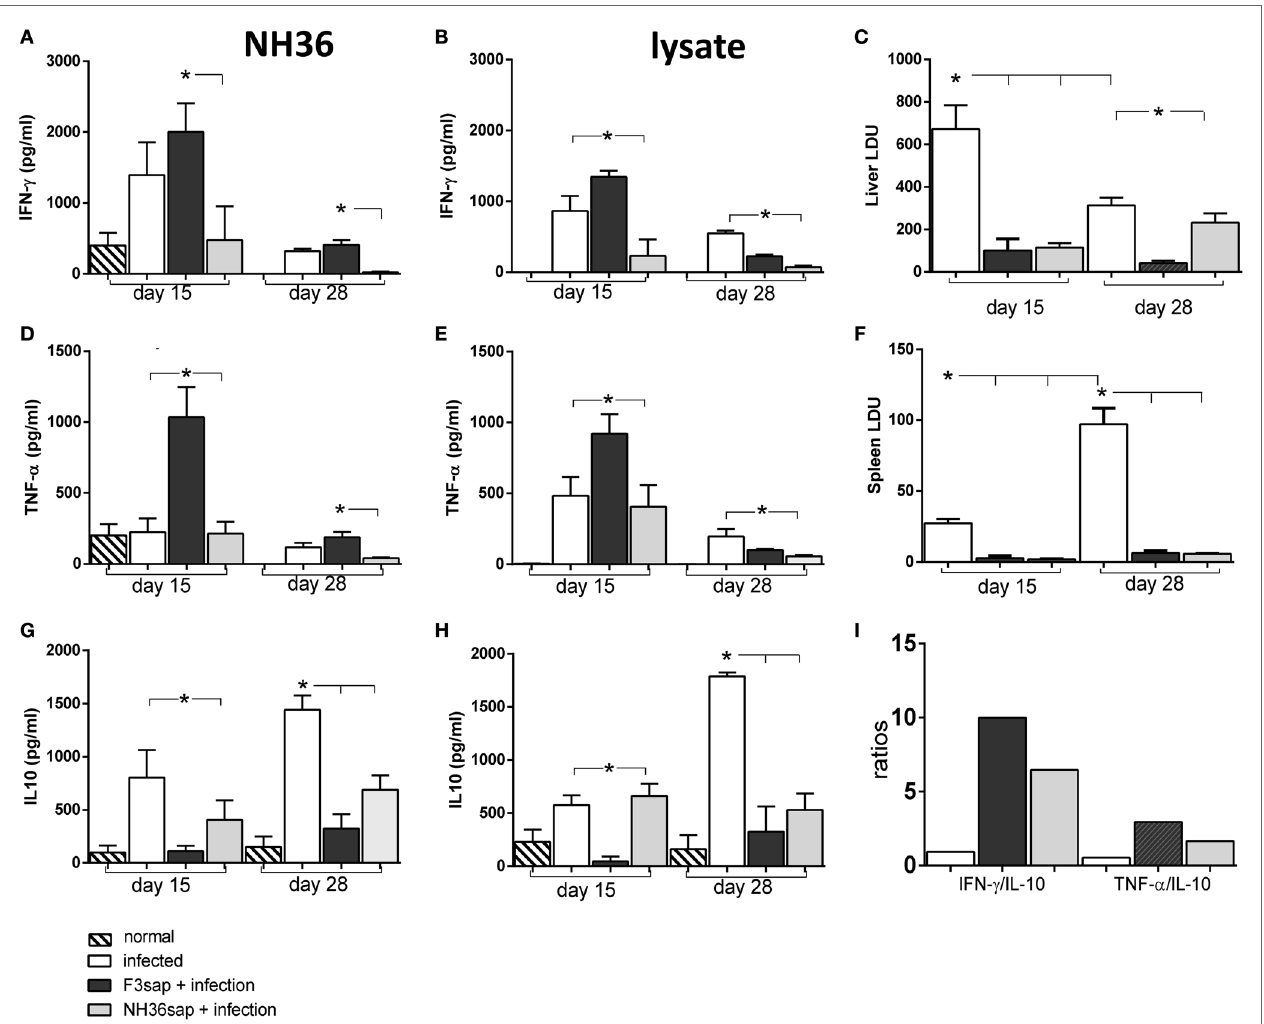
FigUre 6 | Cytokines secreted by splenocytes along the infection. Splenocyte secretion of IFN- γ (a,B) , TNF- α (D,e) , and IL-10 (g,h) were measured in supernatants of in vitro cultures of infected, F3sap and NH36sap vaccinated and infected, in response to NH36 or Leishmania (L.) infantum chagasi lysate antigens, both on days 15 and 28 after infection. LDU values show that the parasite load is maximal in livers at day 15 (c) and in spleens, only on day 28 (F) . Bars represent the mean + SE values of two-independent experiments ( n = 5 mice per treatment in each experiment). Asterisks and horizontal lines show significant differences between treatments as disclosed by Mann–Whitney non-parametrical test. IFN- γ /IL-10 and TNF- α /IL-10 ratios in response to NH36 were calculated on day 15 (i)